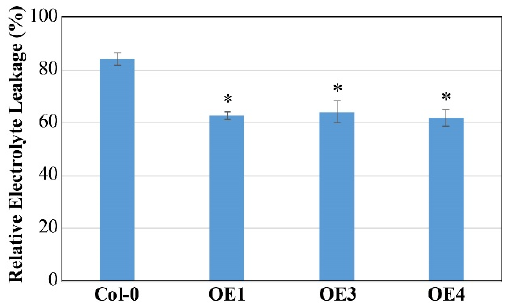
Figure 10. Overexpression of CsATG18b decreased relative electrolyte leakage of transgenic Arabidopsis under cold stress. Relative electrolyte leakages of WT and OE lines were measured after − 20 ◦ C treatment for 5 min. The data are the means ± SE of three independent repeats. * indicates a significant difference at p < 0.05 using an LSD test.